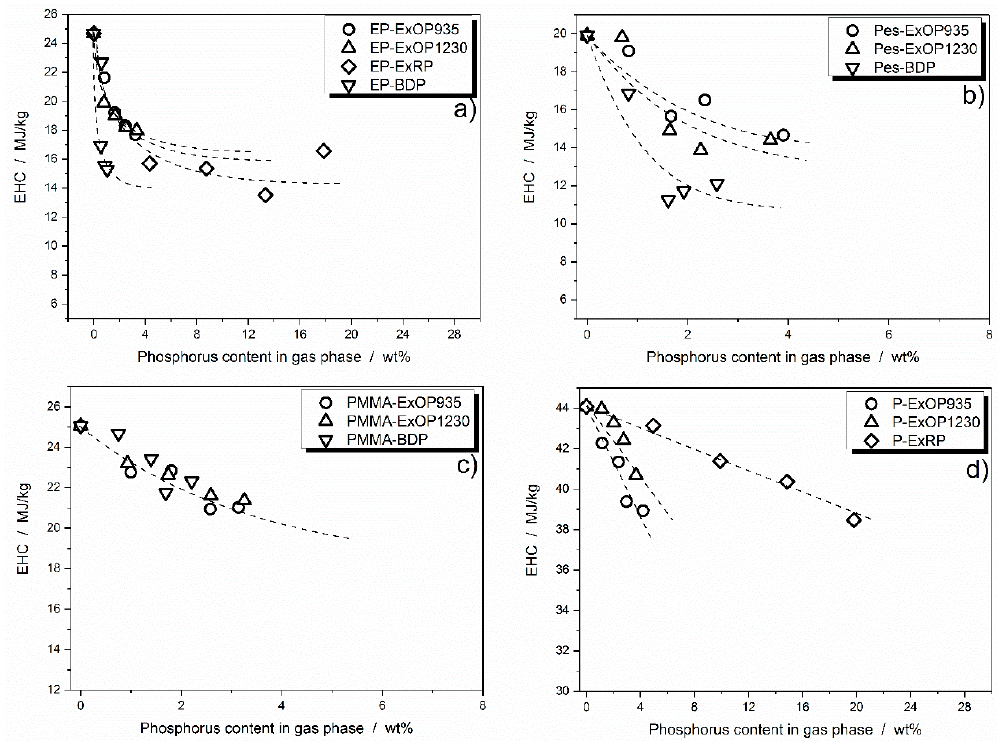
Figure 7. Effective heat of combustion plotted versus the actual amount of phosphorus released into the gas phase during combustion in: DGEBA/IPDA ( a ); polyester resin ( b ); PMMA resin ( c ); and paraffin ( d ).